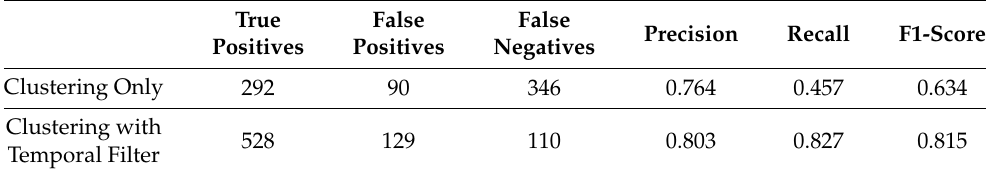
Figure 5. The effect of our offline temporal filter for creating annotations of cars for training networks. In these figures, we show the probability of a ground-truth label being close to a detection ( left ) and the probability of a detection being near a ground-truth label ( right ). Compared to the original clustering-based detector, there is some loss in the precision, which is to be expected from a hand- engineered problem with strict parameters, but the loss of precision is not very high. Unlike the small loss of precision, the temporal filter gains a significant amount of recall compared to the original detector. Note that the temporal filter takes into account future information of detections and therefore only makes sense for offline, supervision-based scenarios. Table 1. The impact of the offline temporal filter on the auto-labelling annotation quality in terms of how many cars were correctly annotated. The filter was assessed on a dedicated evaluation